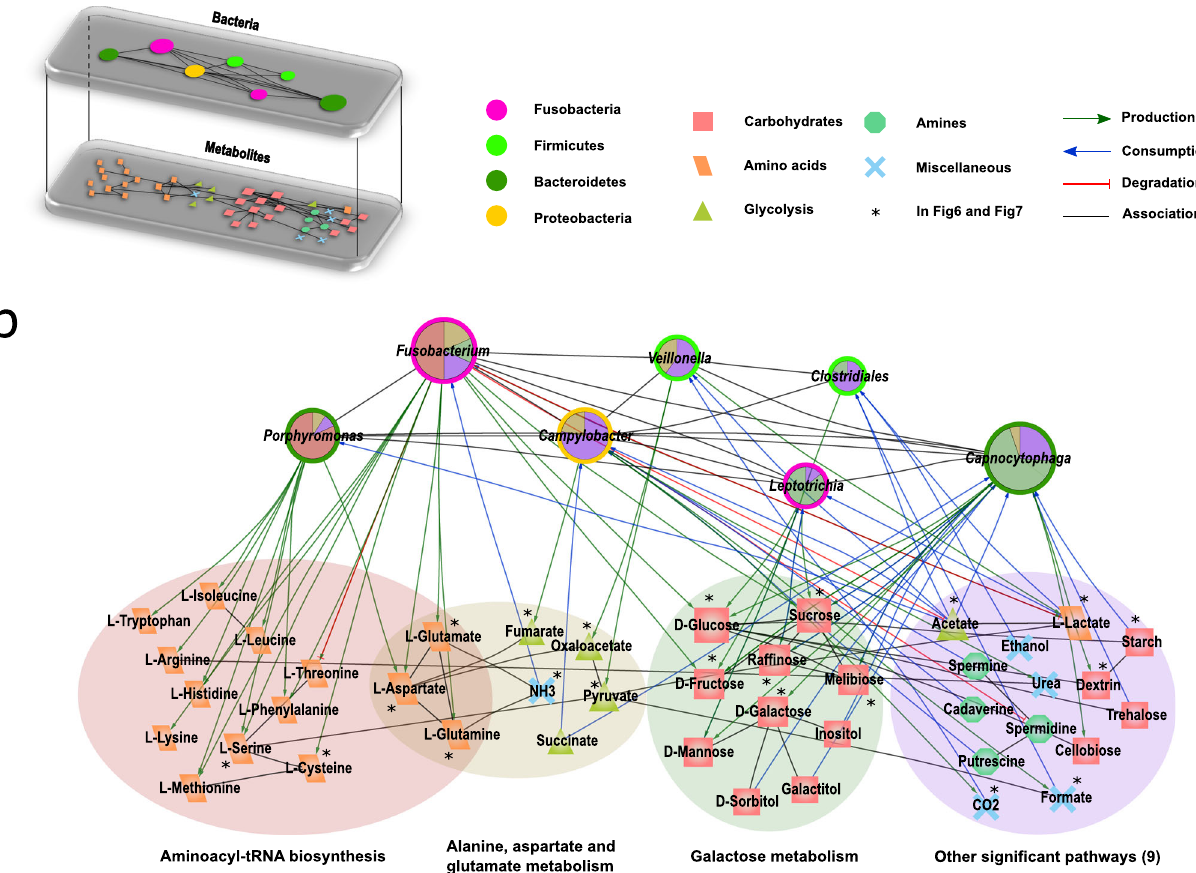
Fig. 6 PPI-affected bacteria-metabolite network in gastric environment of dyspeptic patients. a Multilayer (bacteria-metabolite) network representation: the fi rst layer is derived from Fig. 4 and represents the consensus network (con fi rmed in two datasets: gastric mucosa from Paroni Sterbini et al. 22 and gastric fl uid from Amir et al. 21 ) with PPI-affected bacteria nodes that present information on metabolite interaction in ref. 148 . The second layer represents the network whose nodes are the metabolites in ref. 148 interacting with the bacteria network in the fi rst layer; different node shapes and colours refer to different metabolite classes (carbohydrates, amino acids, glycolysis, amines, miscellaneous). b In depth visualization of the bacteria-metabolite network interactions. The metabolites are grouped according to their involvement in signi fi cant pathways. For discernibility, the metabolites are arranged according to three signi fi cant pathways ( p < 0.05 after Benjamini correction as result of a metabolite pathway enrichment analysis by a one-sided test) and a fourth group that encloses altogether nodes associated to other signi fi cant pathways (please refer to the method section: Bacteria-metabolite multilayer network construction and metabolite pathway analysis); note that only metabolites present in signi fi cant pathways are here displayed. For more information, please refer to Supplementary Fig. 17 and Supplementary Data 6. The bacteria node stroke color is associated to the phyla information as in Fig. 4, whereas the different colours in the inner fi ll are associated to the different pathways and their extent is proportional to the number of metabolites that the bacterium connects with in the different displayed